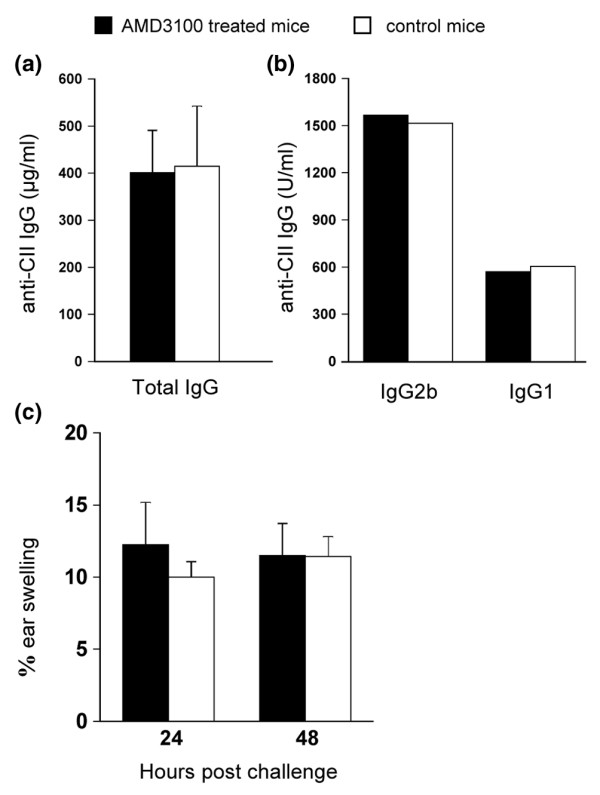
AMD3100 in wild-type mice does not interfere with the humoral or the cellular response. At the end of the two week treatment (day 41), blood was collected from five mice out of each group. (a) Sera of individual mice were analyzed for total anti-CII IgG, using an absolute standard. Bars represent averages plus standard error of the mean of five mice. (b) Equal quantities of the sera were pooled for detection of anti-CII IgG2b and IgG1, using a standard in arbitrary U/ml; standard = 1,000 U/ml. (c) Delayed type hypersensitivity reactivity against CII. Ten mice were immunized with CII/complete Freund's adjuvant and implanted with osmotic pumps containing AMD3100 or PBS on day 7. On day 17 after immunization, five mice in each group were challenged with 10 μg of CII in the right ear and vehicle in the left. Delayed type hypersensitivity responses were measured as the percentage of ear swelling (i.e. 100 × the difference between the increase of thickness of the right and the left ear, divided by the thickness of the ear before challenge) at the indicated times. Bars represent averages ± standard error of the mean for five mice.